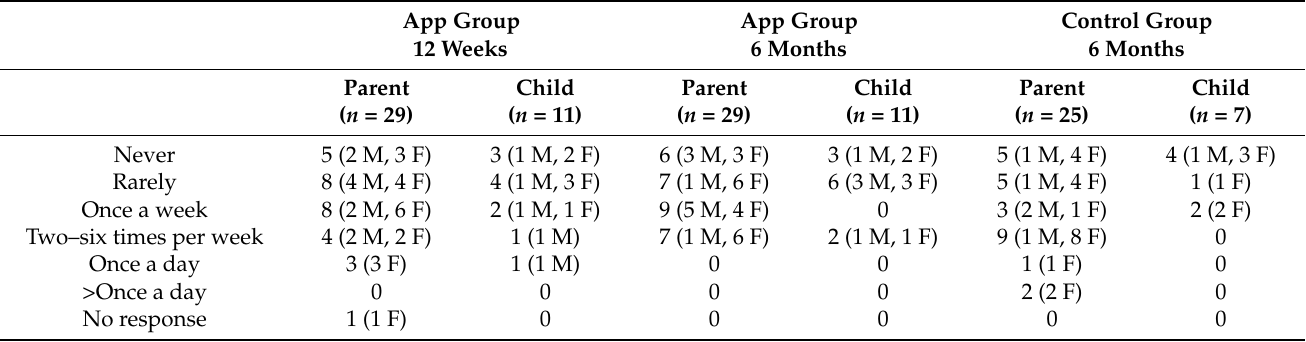
Table 3. Frequency of using app.